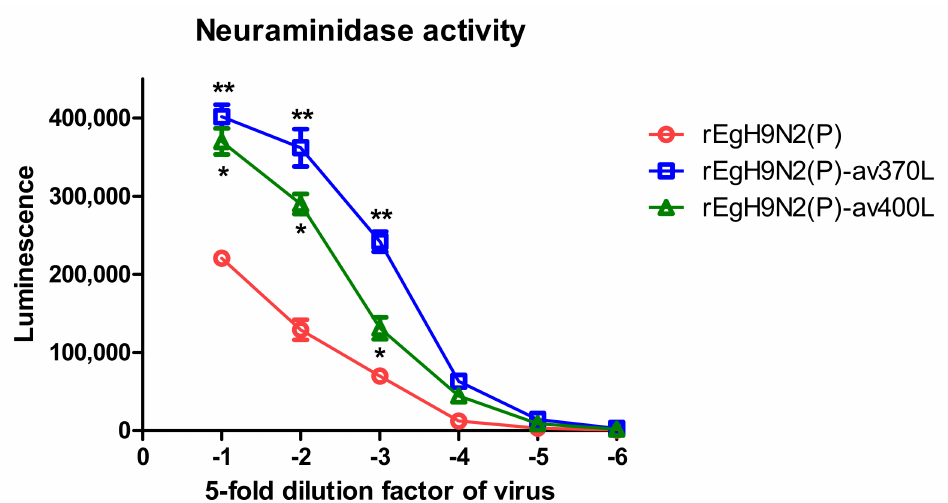
Figure 5. Reverse mutations in the 370-loop and 400-loop of NA increase neuraminidase activ- ity via increased affinity to substrate. The 128(2 7 ) HAU of each virus was diluted five-fold, and neuraminidase activity was measured in triplicate using the NA-star™ Influenza Neuraminidase In- hibitor Resistance Detection Kit. *, rEgH9N2(P)-av370L was significantly different from rEgH9N2(P); **, rEgH9N2(P)-av370L was significantly different from the others ( p <